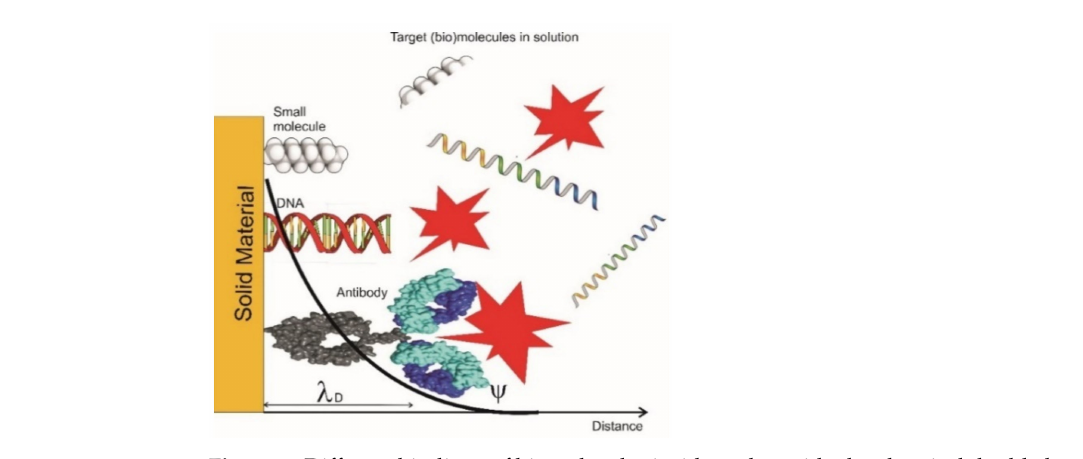
Figure 3. Different bindings of biomolecules inside and outside the electrical double layer. Only the changes inside the electrical double layer are detected [l D , Debye length]. Modified from